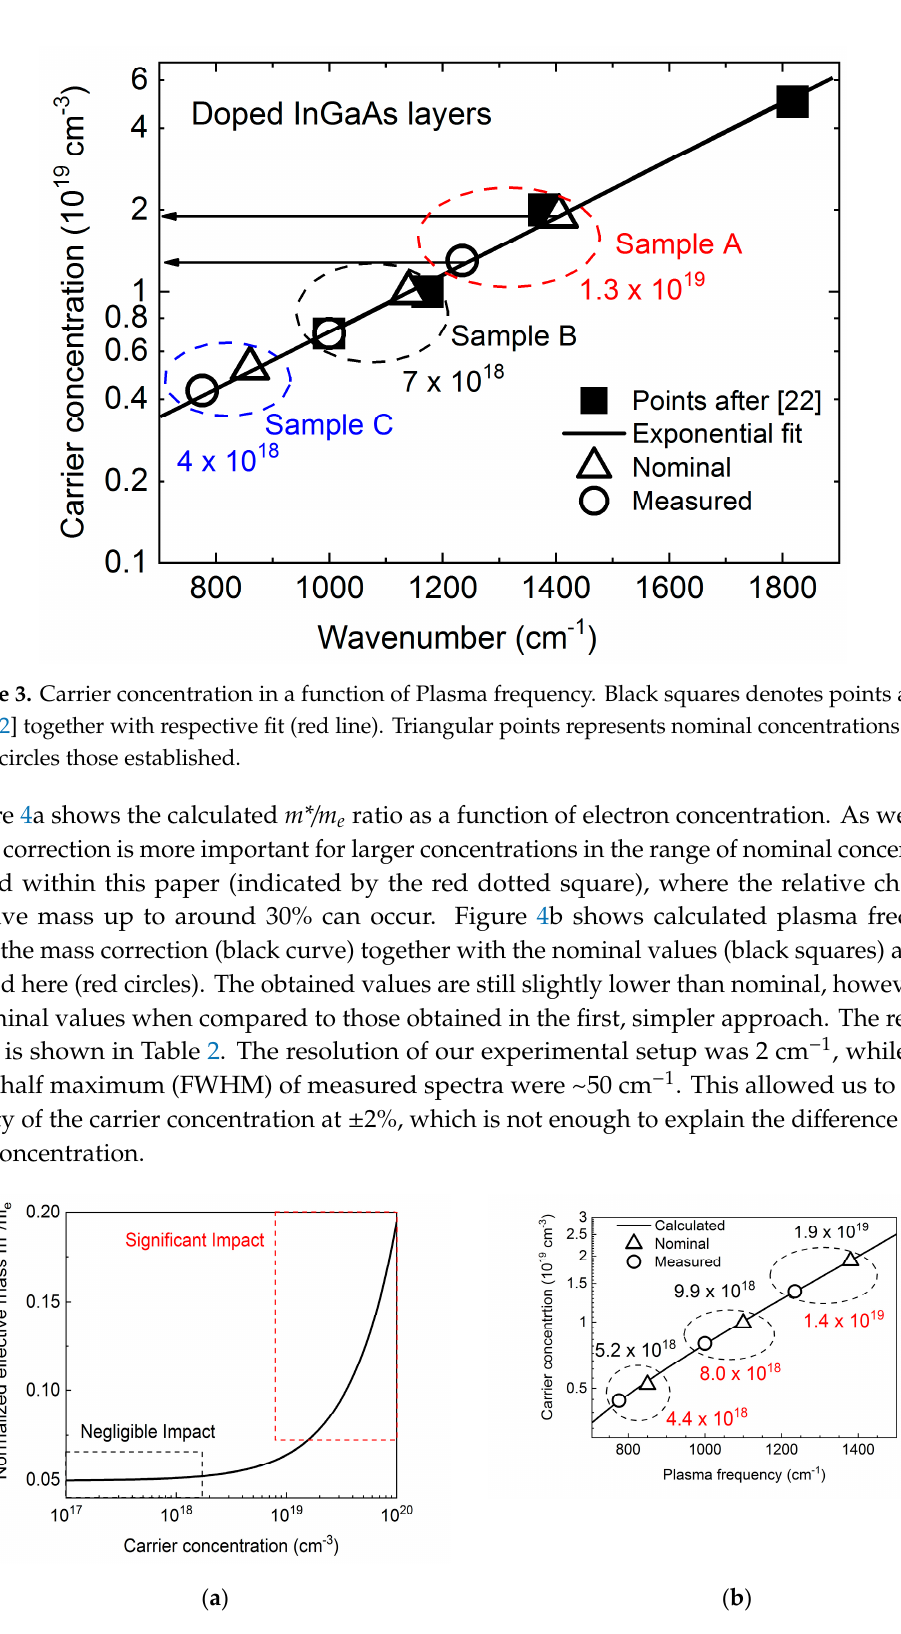
Figure 4. ( a ) Electron mass changes as a function of their concentration after Equation (2); ( b ) Plasma frequencies as a function of electron concentration. Black curve represents calculated Plasma frequencies assuming mass correction shown in panel ( a ). Open triangles depicts nominal values and open circles those measured . Table 2. The samples’ description and growth protocol.